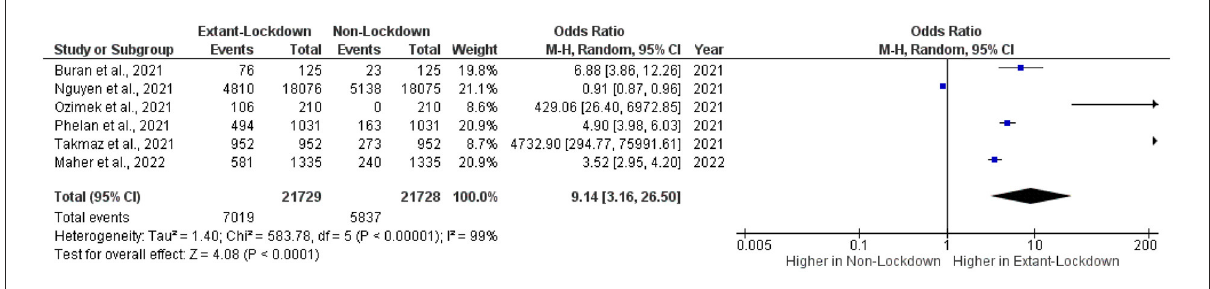
FIGURE2 Effect of COVID-19 pandemic lockdowns on cycle length changes.